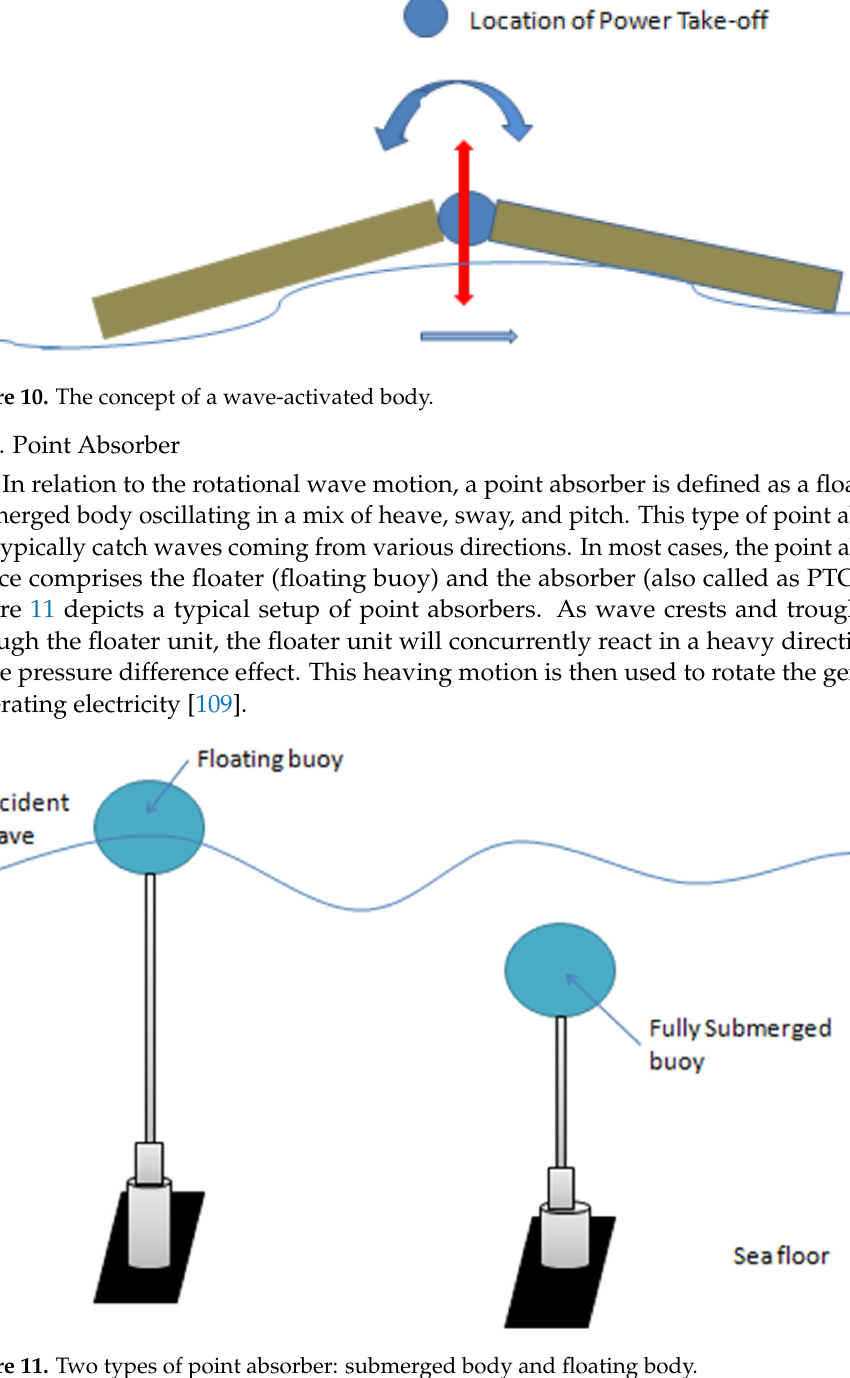
Figure 11. Two types of point absorber: submerged body and floating body.